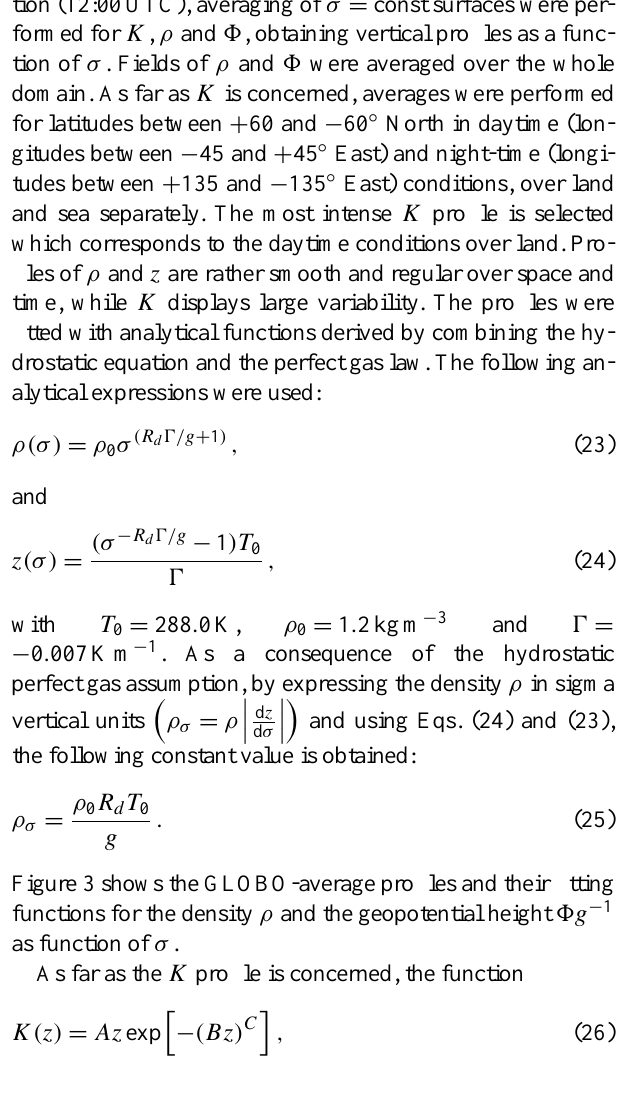
Figure 2. Values of integration time step 1t for the diffusivity pro- Fig. 2. Values of integration time-step ∆ t for the diffusivity profile file shown by the red curve. The green line shows the contribution of shown by the red curve. The green line shows the contribution of Eq. (19), the blue line the contribution of Eq. (20), and the black line Eq. (19), the blue line the contribution of Eq. (20) and the black line the combined condition (Eq. 21, with ∆ T =432 s and C T =0 . 01 ). the combined condition (Eq. 21, with 1T = 432 s and C T = 0 . 01). the problem, an additional constraint is used to make the al- of 362 × 242 cells and 50 vertical levels evenly spaced in σ ) gorithm non-local (or less local ). Using the ∆ t 0 computed at 375 starting at 11 March 2011 00:00 UTC. After 36 h of simula- the particle position at time t , two other time-step ( ∆ t + and ∆ t − ) are evaluated at the positions: